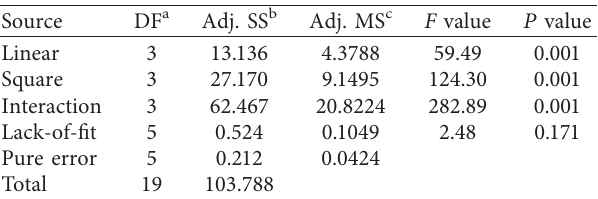
Table 3: The ANOVA results for evaluation of mathematical models obtained by response surface